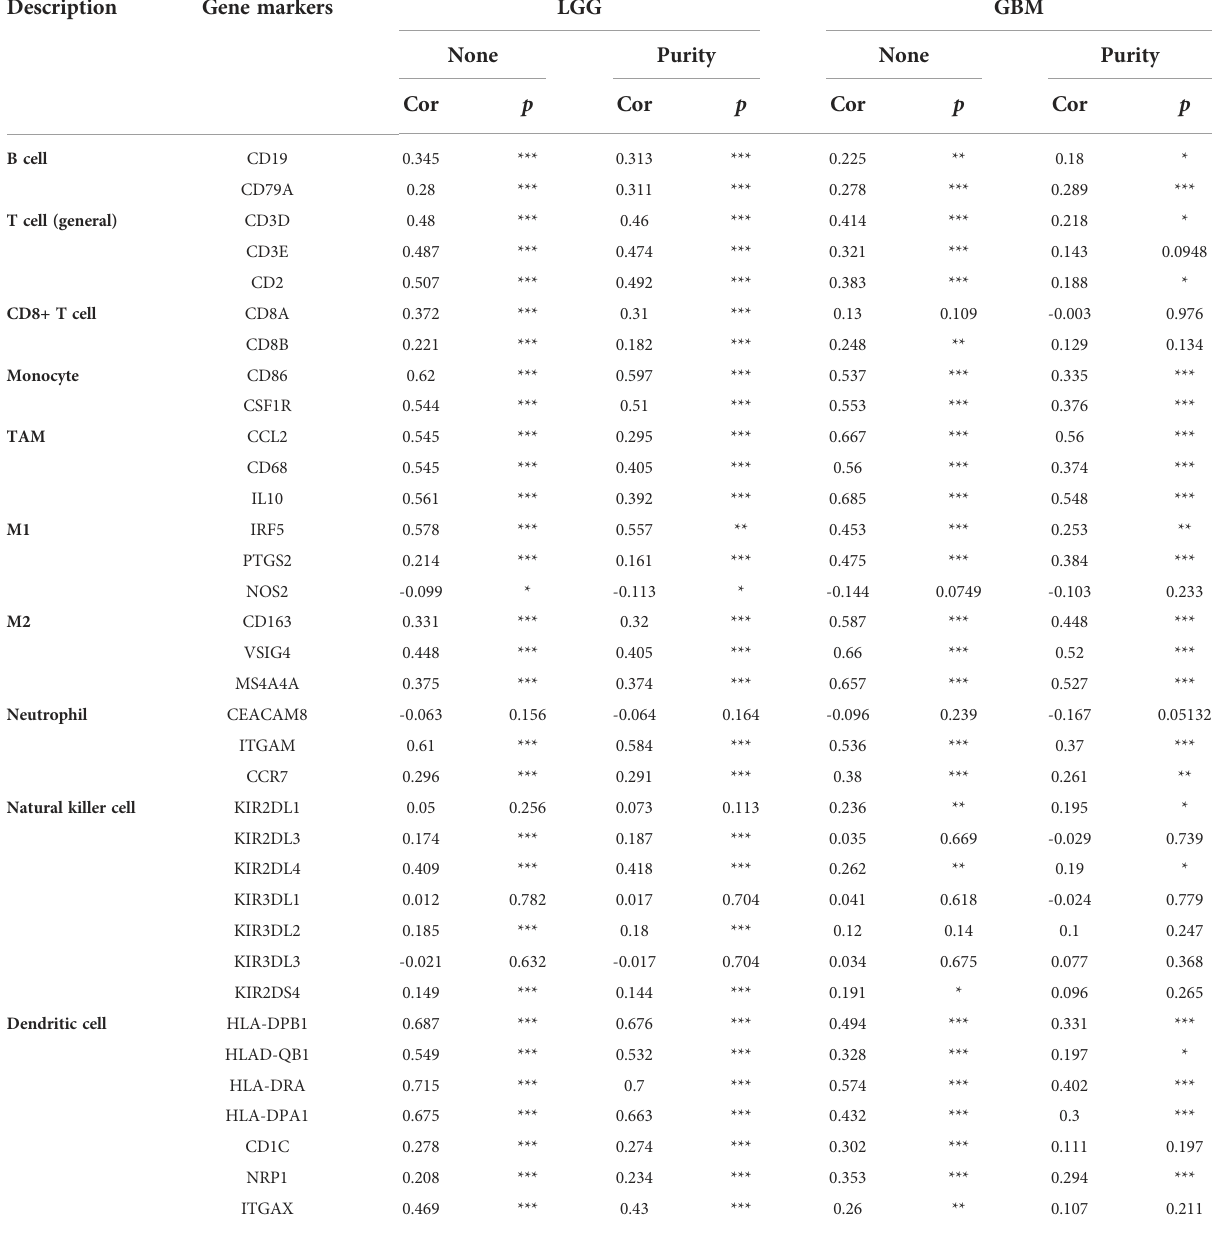
TABLE 1 Correlation analysis between hepcidin and gene markers of immune cells in LGG and GBM in TIMER.